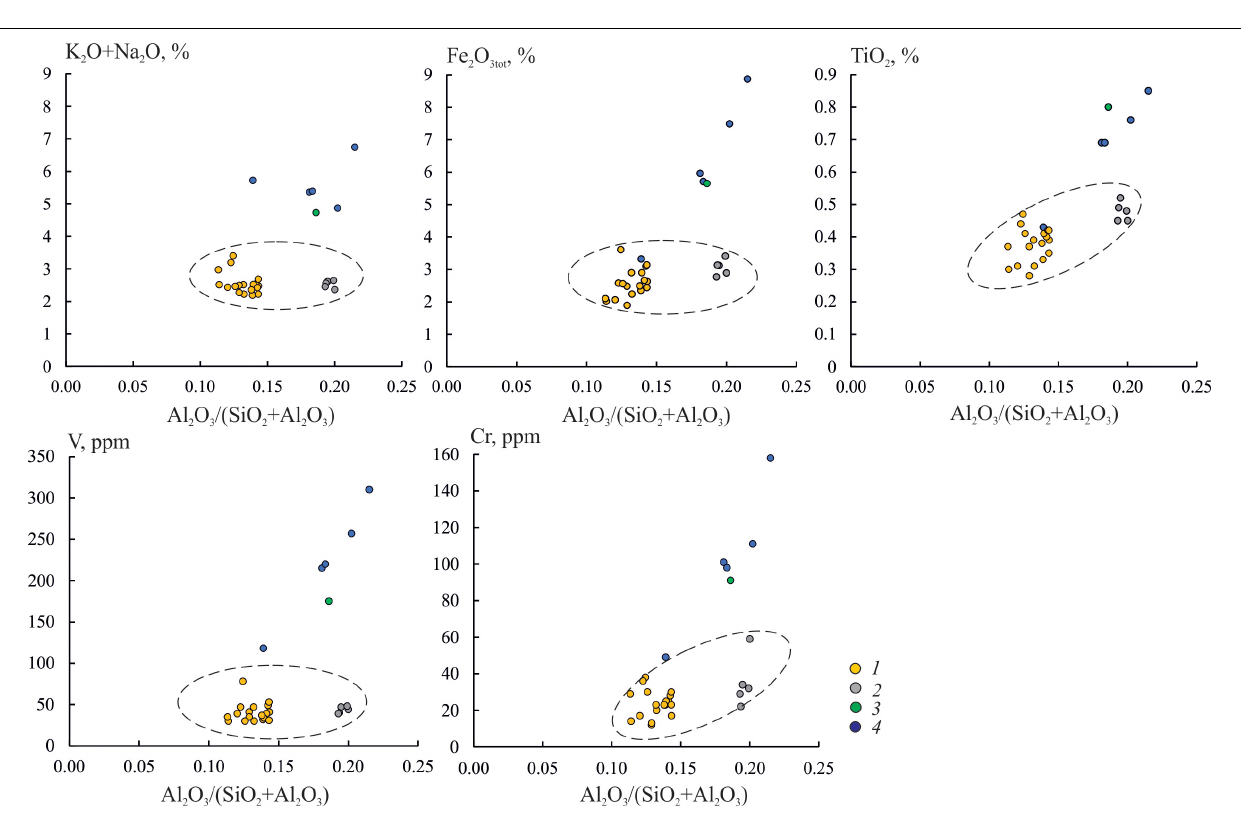
Table 1 give a higher temperature which can reach of 70–80 ◦